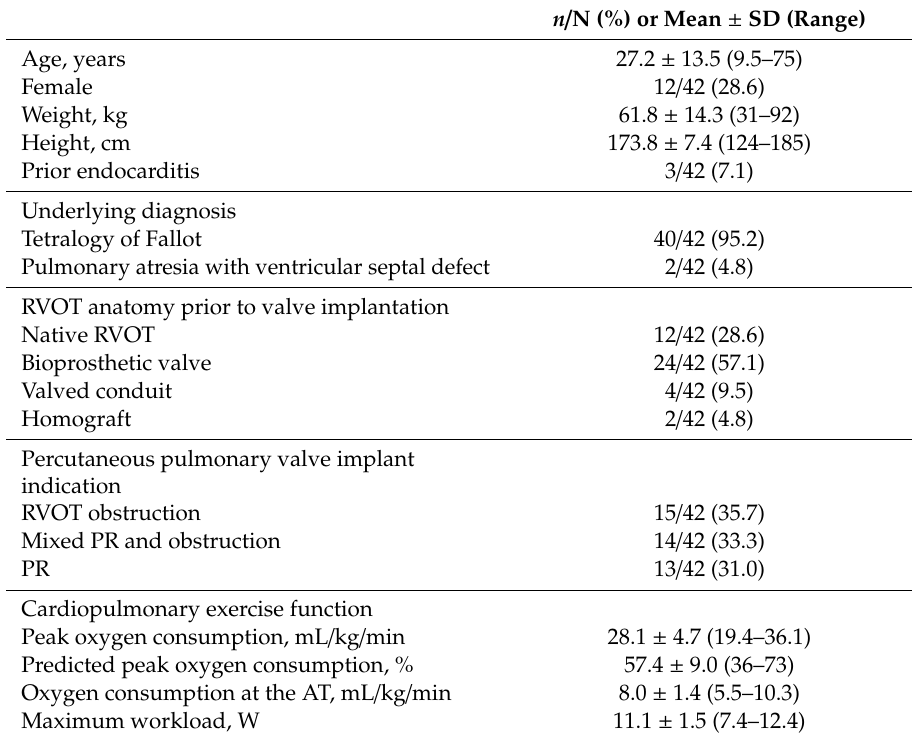
Table 1. Patient